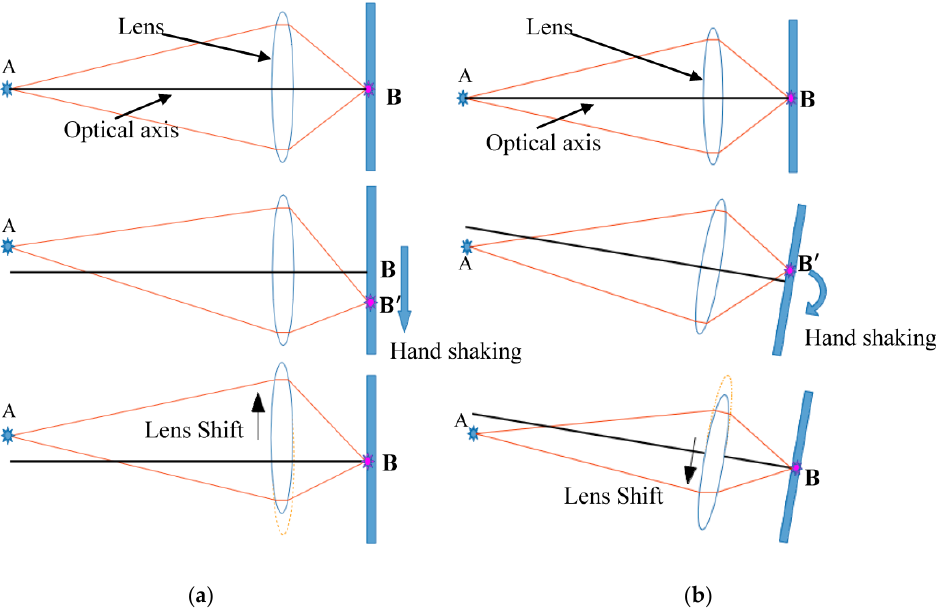
Figure 3. The optical working principles of OIS ( a ) under translational disturbance from hand shaking; ( b ) under rotational disturbance.